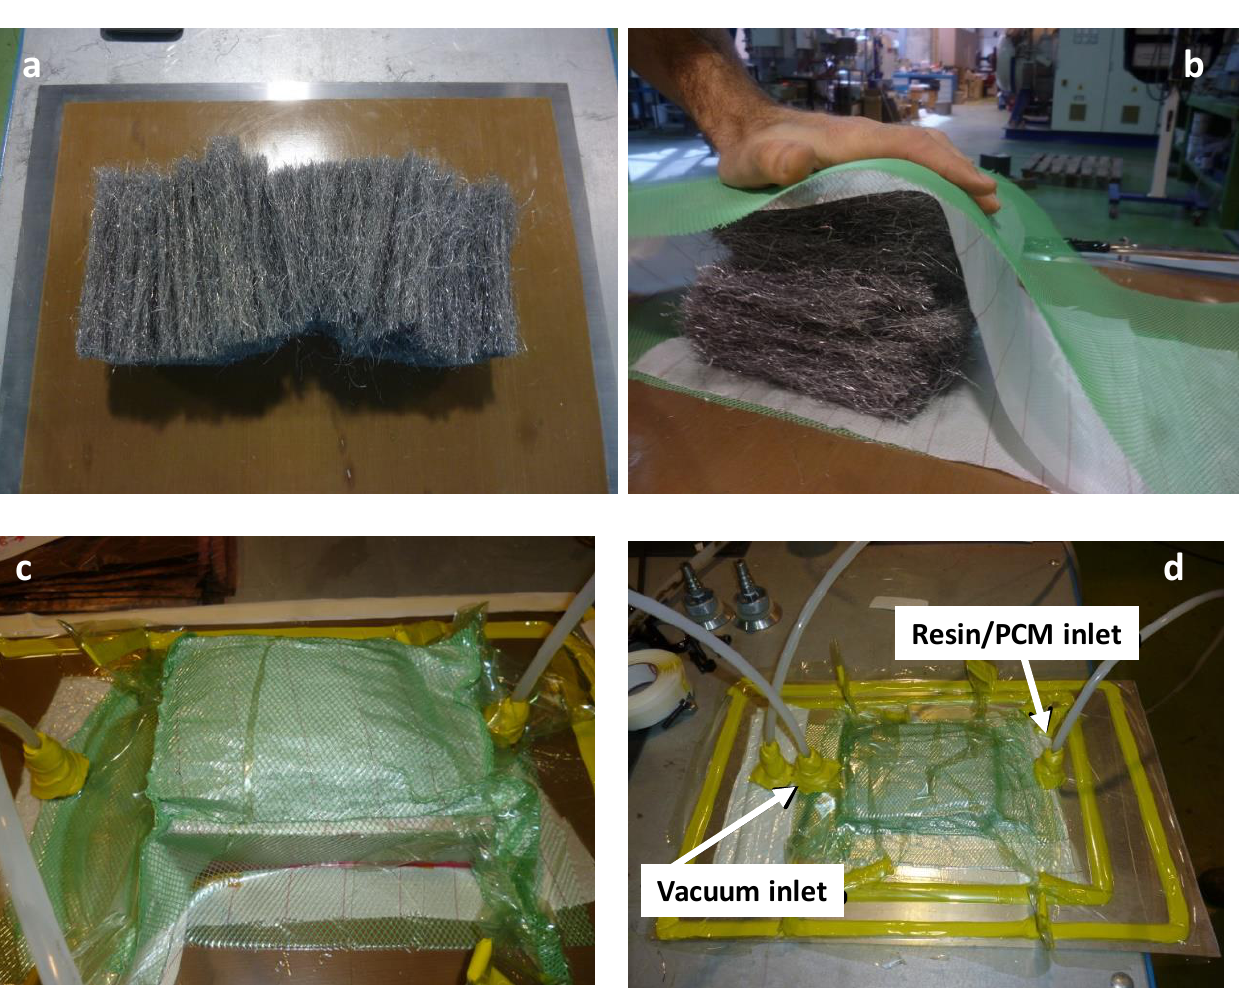
Figure 7. Production of metal wool-resin compound. ( a ) Metal fibers, ( b ) insertion in plastic bags, ( c ) vacuum production, and ( d ) resin infiltration.